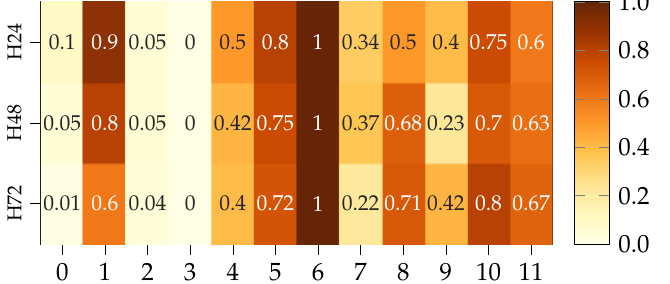
Figure 9. Heatmap features top performance.